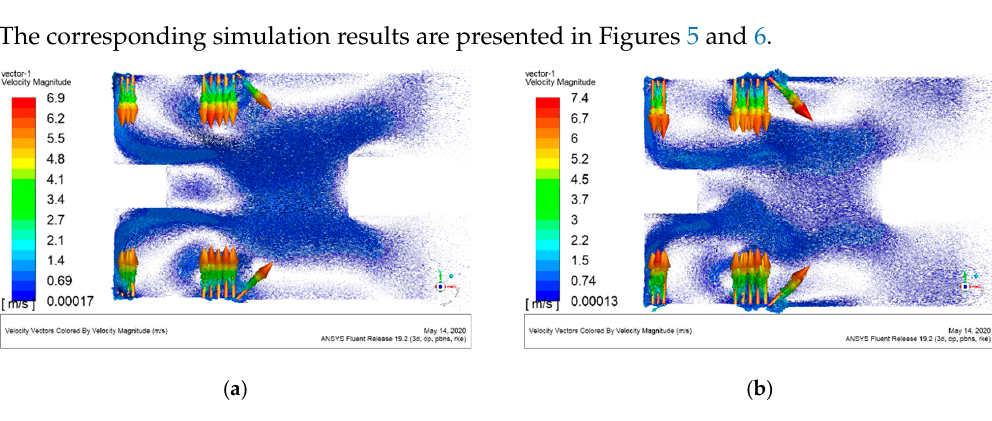
Figure 6. Velocity vector diagrams of the flow field in the beam expanding system for plans D and E: ( a ) velocity vector diagram for plan D; ( b ) velocity vector diagram for plan